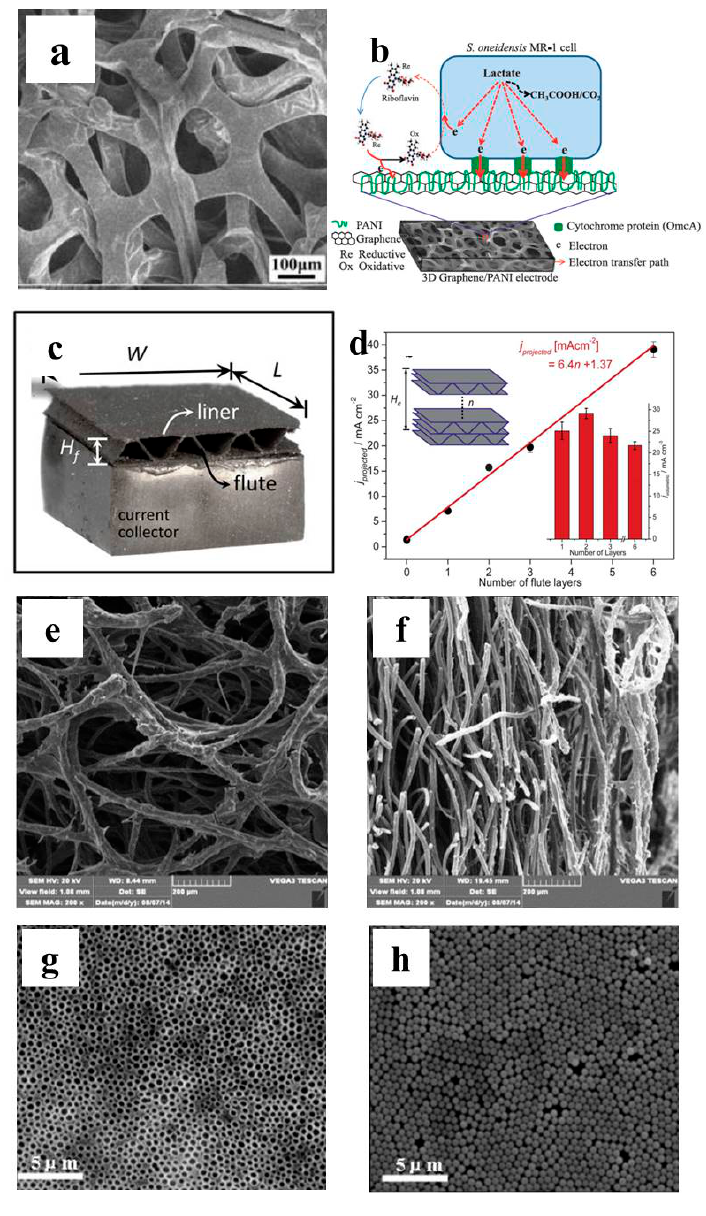
Figure 5. ( a ) SEM image of macroporous structured graphene/PANI monolithic electrode fabricated from in-situ CVD graphene synthesis on nickel foam template and followed by PANI chemical polymerization; ( b ) Schematic illustrating the interface electron transfer between S. oneidensis MR-1 and graphene/PANI electrode [92]; ( c ) Photographic image of single layered corrugated carbon electrode; ( d ) Dependence of BES steady state current density on the number of layered corrugated carbon electrode [93]; ( e , f ) front and side-surface SEM image of carbonized towel electrode [94]; ( g , h ) SEM image of SiO 2 template and porous carbon with defined pore size [95]. Reproduced with permission from American Chemical Society, the Royal Society of Chemistry and Elsevier.